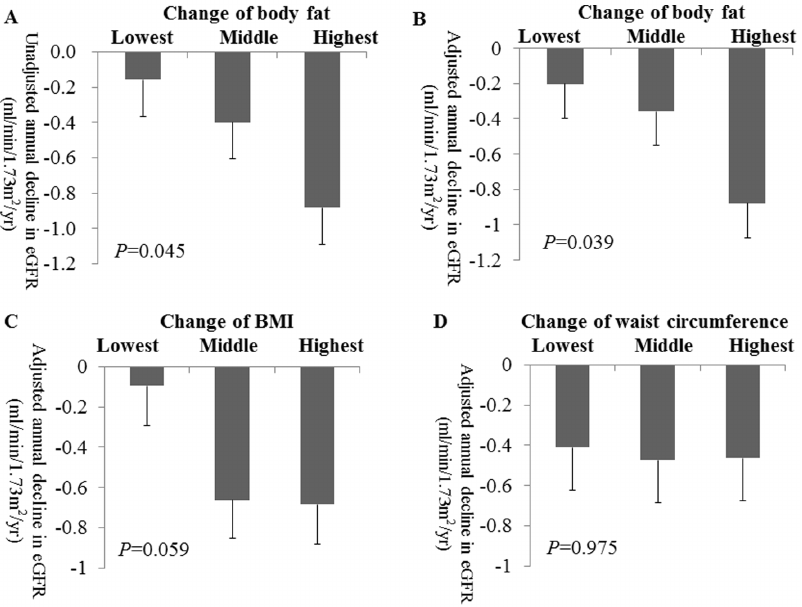
Figure 2. Annual decline in eGFR is correlated with change of body fat. (A) Unadjusted annual decline in eGFR amongst tertiles of change in body fat percentage. (B) Adjusted annual decline in eGFR among tertiles of change in body fat percentage. (C) Adjusted annual decline in eGFR among tertiles of change in BMI. (D) Adjusted annual decline in eGFR among tertiles change of waist circumference. Error bars indicate standard error of mean. Annual decline in eGFR was adjusted using analysis of covariance (ANCOVA) by age; sex; diabetes; hypertension; smoking history; and baseline values of systolic blood pressure, fasting glucose, body mass index, serum creatinine, triglyceride, high-density lipoprotein. doi:10.1371/journal.pone.0084052.g002 PLOS ONE |